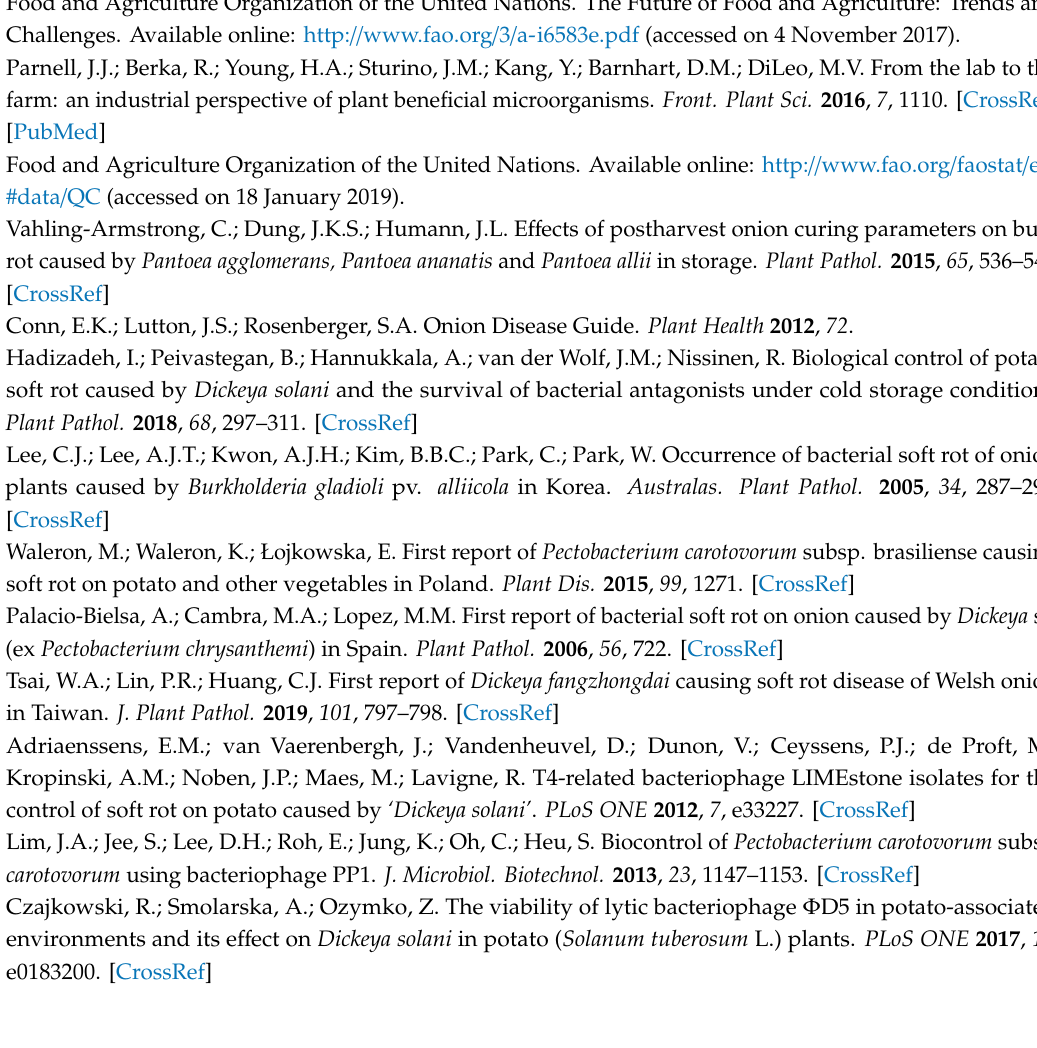
Table S3: Features of annotated bacteriophages genomes in this study by RAST, Virulence Finder, Res Finder 3.1 and ToxFinder, Table S4: RAST